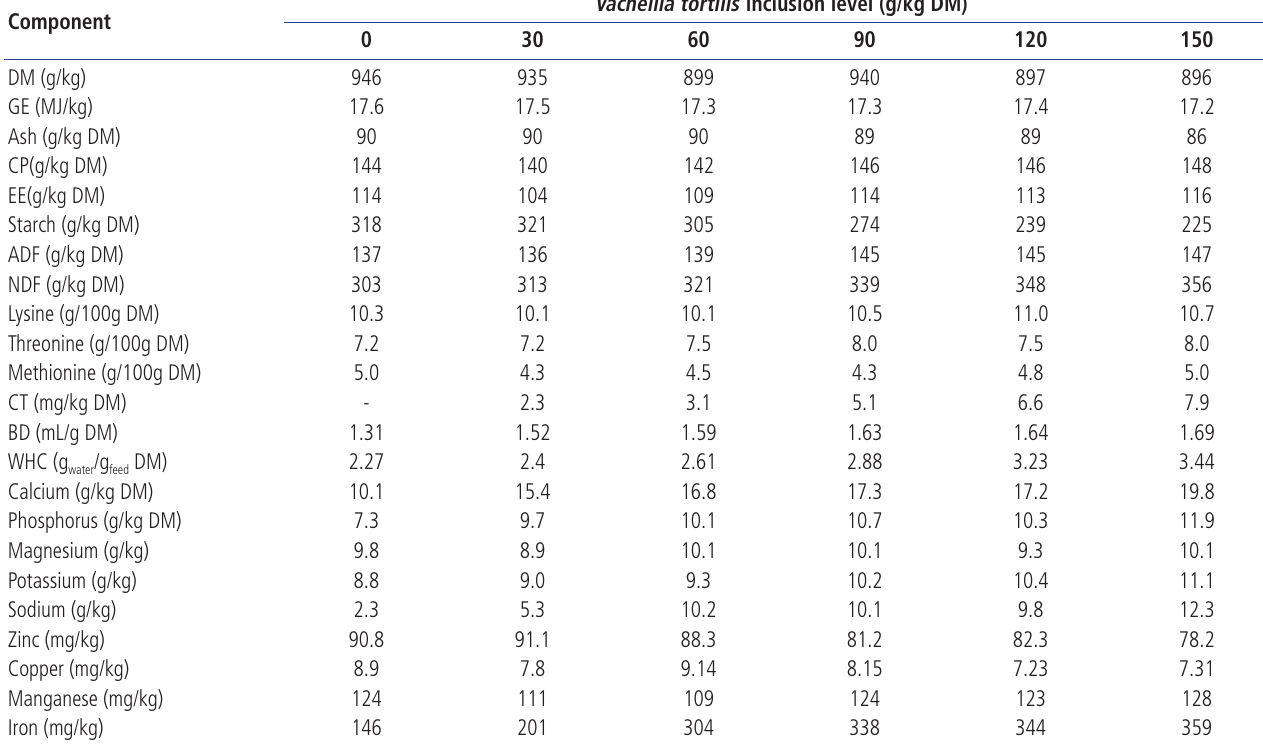
Table 2. Nutrient composition of experimental diets Component